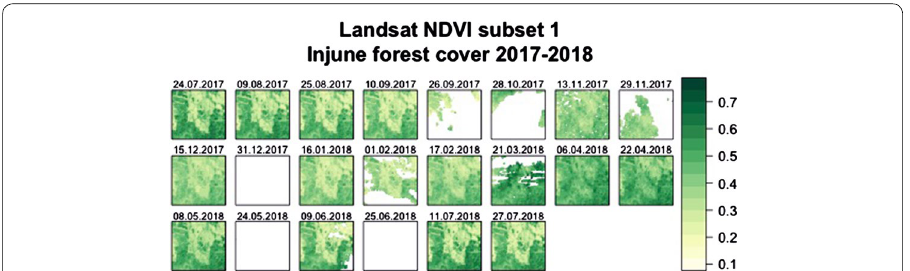
Fig. 3 NDVI of the same area within Landsat 8 images at neighbourhood scale for approximately 1 year. The NDVI values are shown by the scale from light green around 0 to darker green as NDVI approaches 1. White regions indicate the data are missing due to cloud